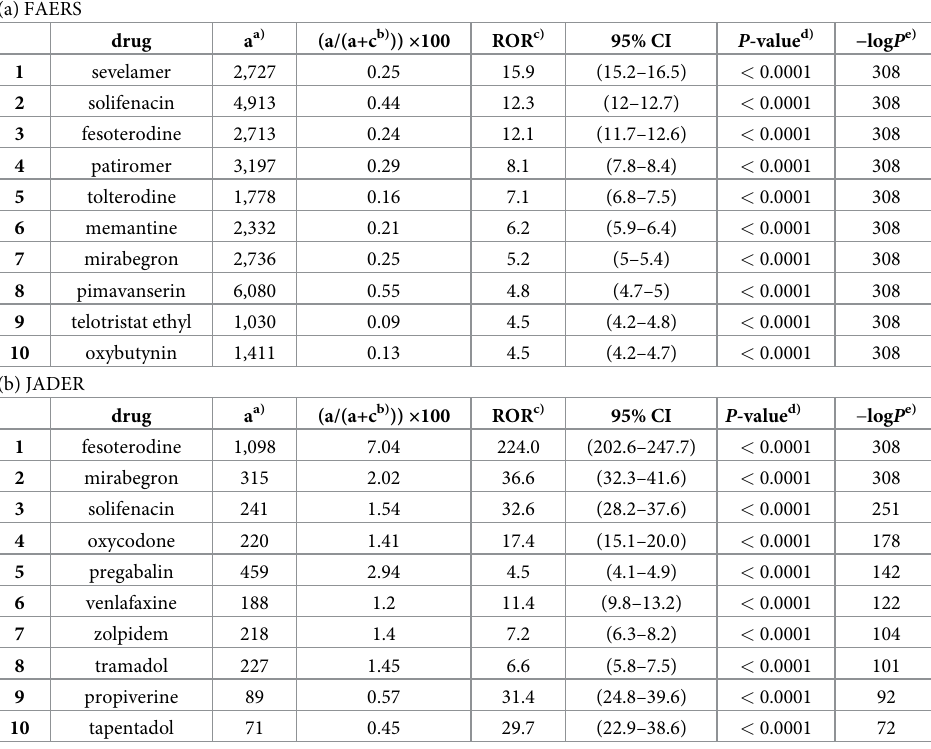
Table 2. Major suspected drugs of ALL. (a) FAERS (b)